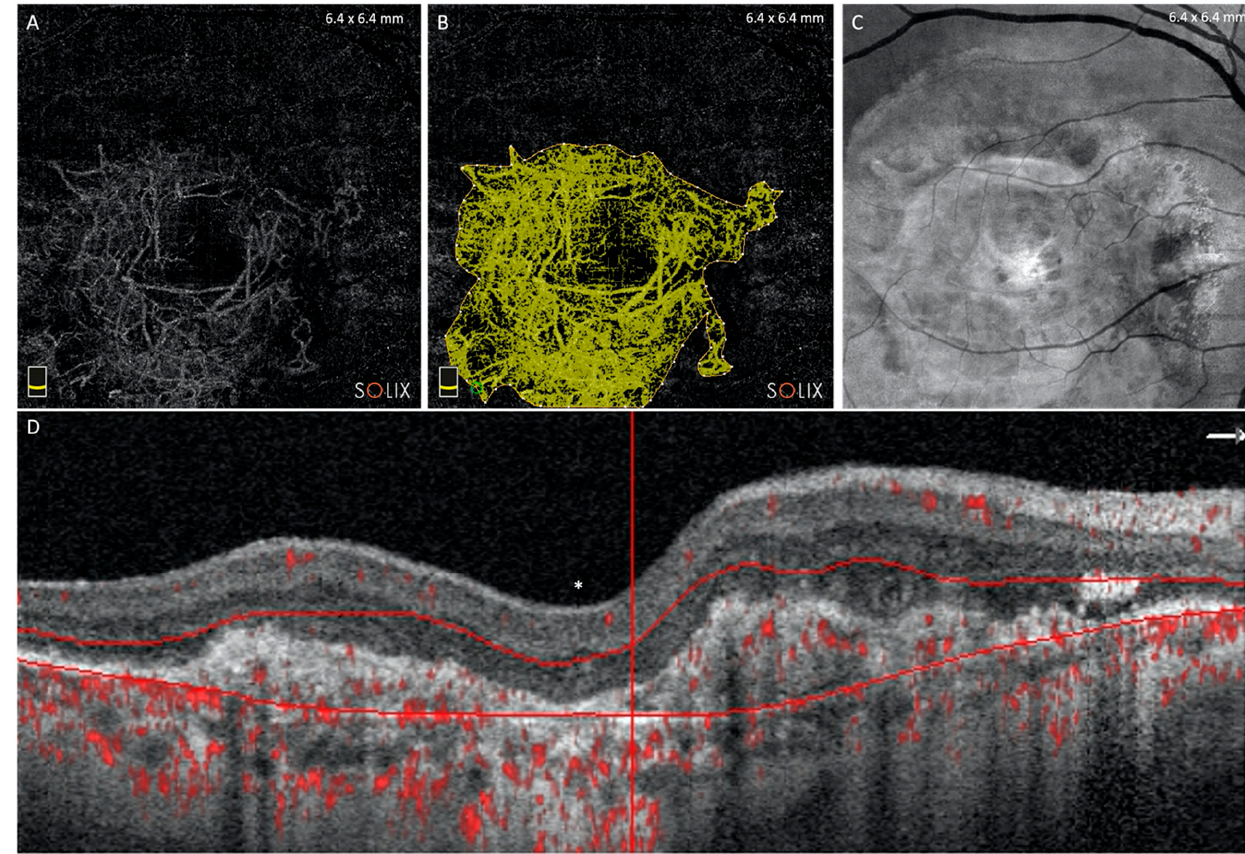
Figure 3. Advanced exudative AMD eye with macular neovascularization ( A ), neovascularization area by semi-automated measurement (yellow area) ( B ), enface and B-scan corresponding in outer retinal slab ( C – D ). * represents the fovea.